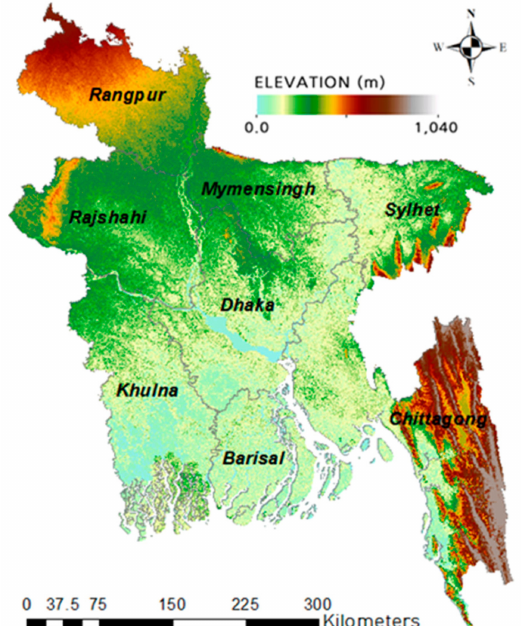
Figure 1. The elevation map of Bangladesh (data source: https: // SRTM.csi.cgiar.org).